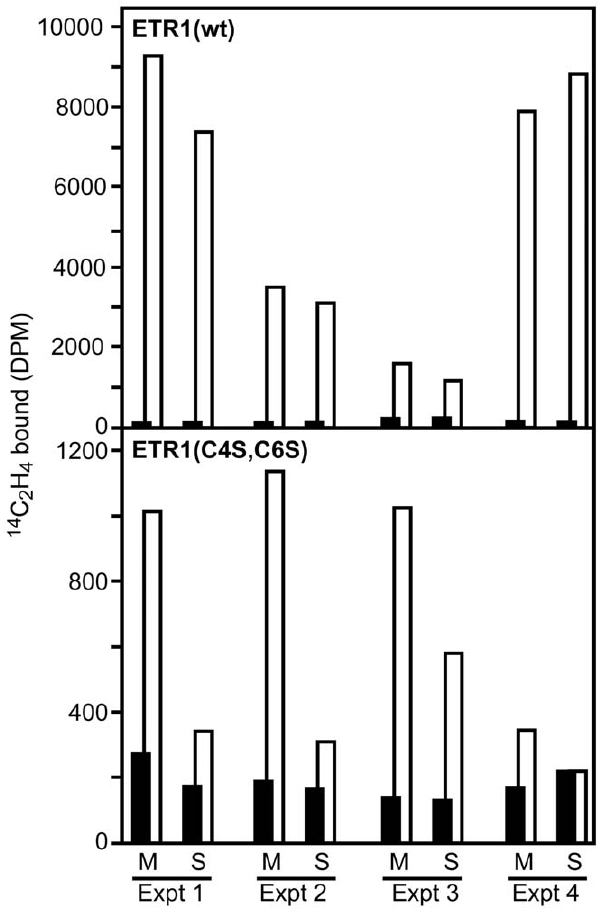
Figure 4. Effect of ETR1 disulfide bonds on the ability of the receptor to bind ethylene. Membranes were isolated from transgenic yeast expressing either wild-type ETR1 (wt) or ETR1(C4S,C6S). Each membrane sample was separated into equal portions, and portions incubated in the absence (M) or presence of 5 mg/mL SB-16 to solubilize the receptor (S), prior to being examined for ethylene binding. Saturable ethylene binding is indicated as the difference between samples treated with 14 C-ethylene (white bars) and identical samples treated with 14 C-ethylene and excess 12 C-ethylene (overlap- ping black bars). Results from four independent experiments are shown, with duplicate samples being examined in each experiment.